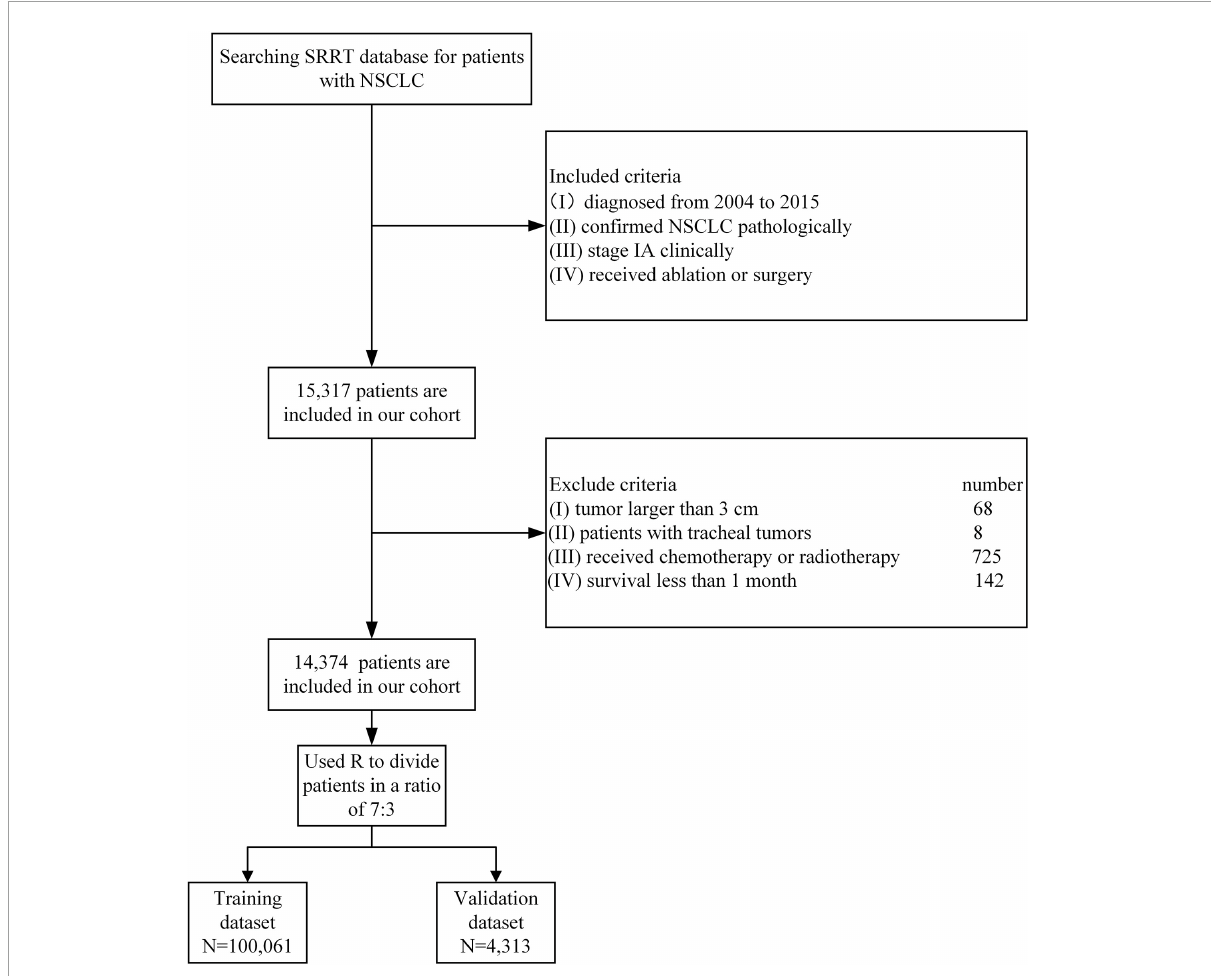
FIGURE1 Flow-chart illustrating the steps to extract the case of NSCLC from